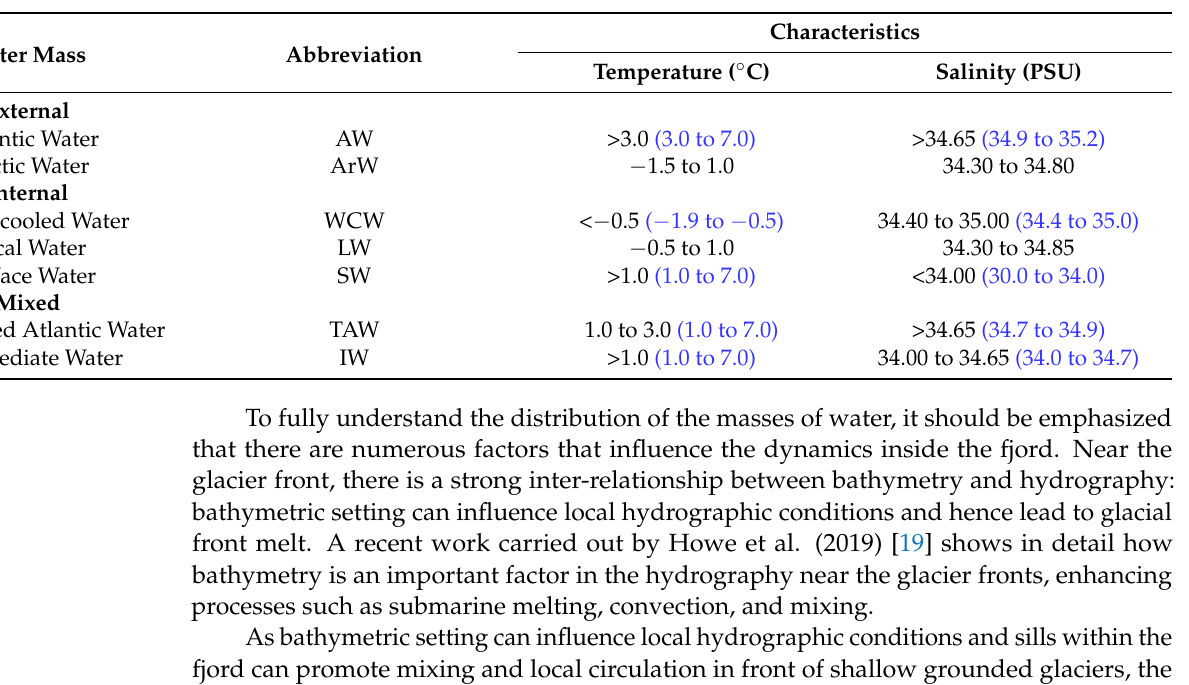
Table 1. Comparative table summarizing the classification of water masses found in the literature. In particular, the values are obtained from [12,19]. The values shown in blue in the brackets are obtained from [14], adapted from [20].